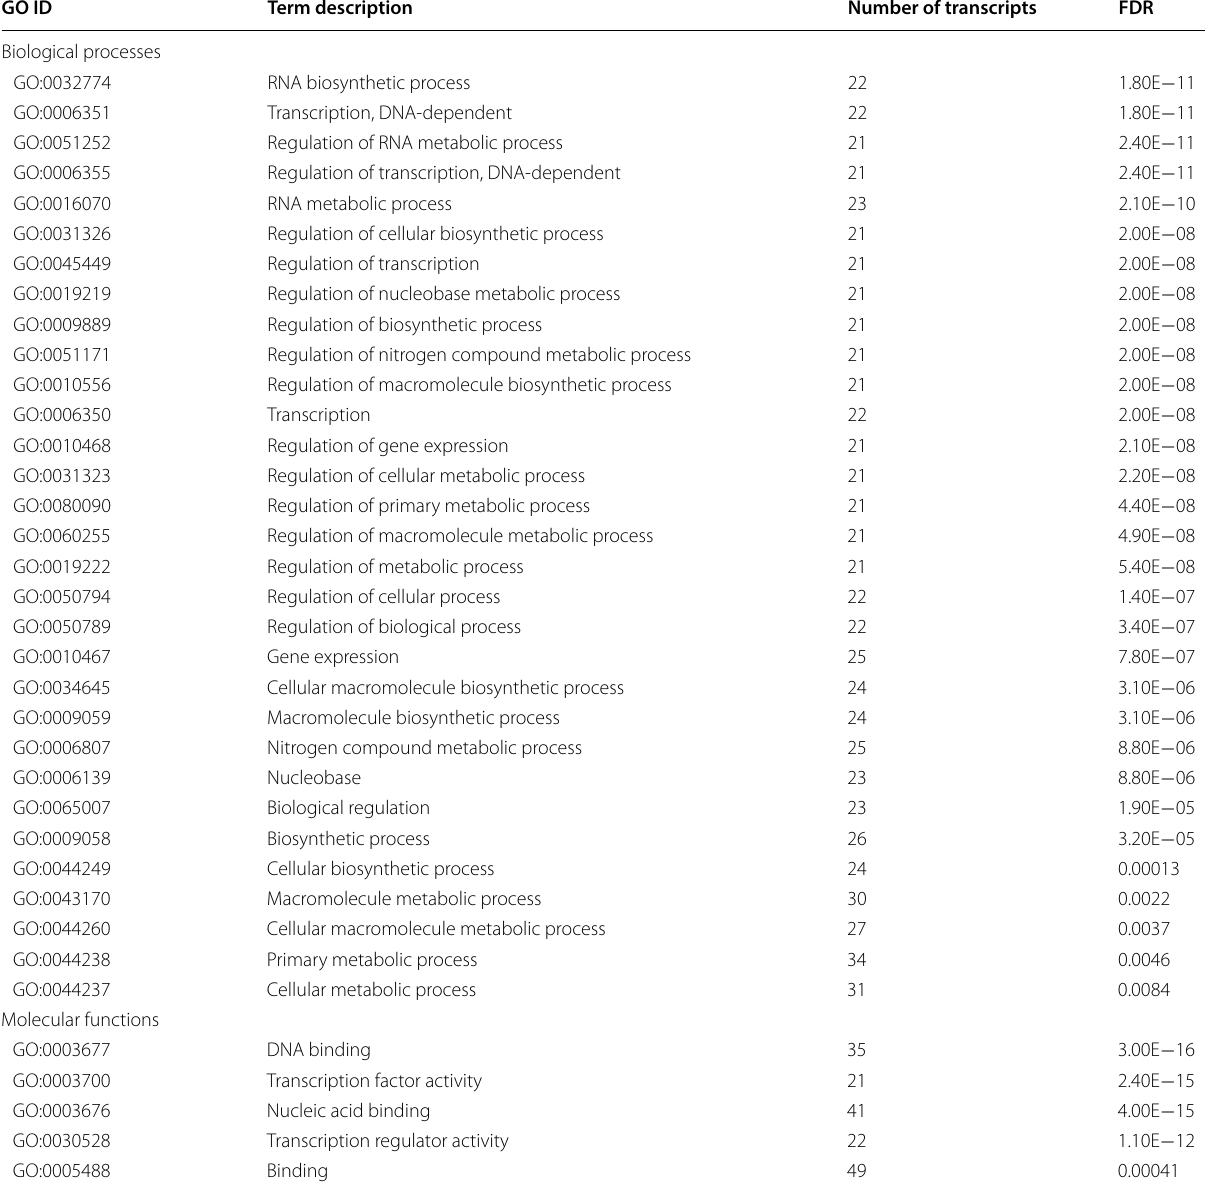
FDR values indicate the relevance of the function, with lower values suggesting higher relevance